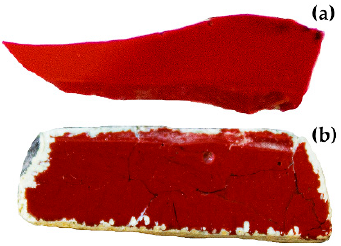
Figure 26. Comparison of two fragments of copper red glass—sealing wax ( a ) and brick red ( b